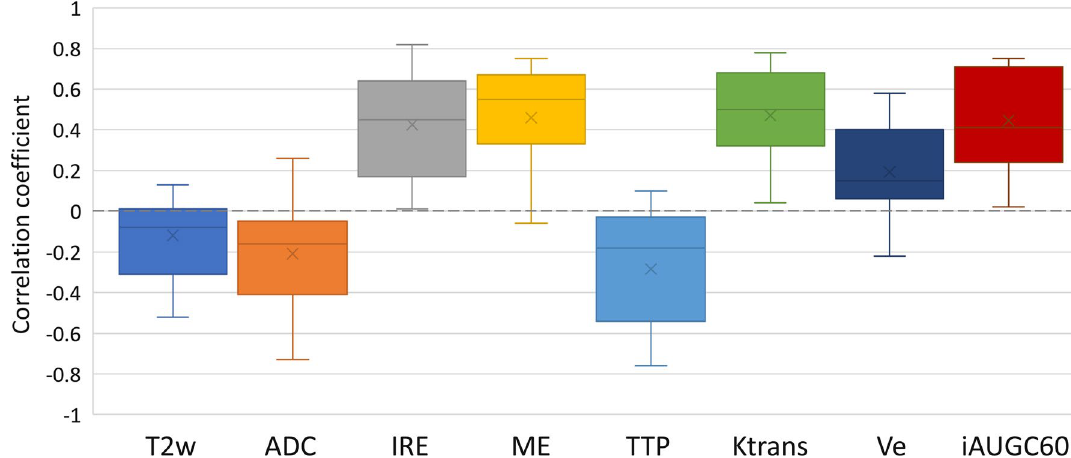
Fig. 2 Box and whisker plot showing the range of Spearman correlation coefficient values computed between PET SUV and MRI parameter voxel values. Outlier values were excluded, and mean data values are shown with an ‘ x